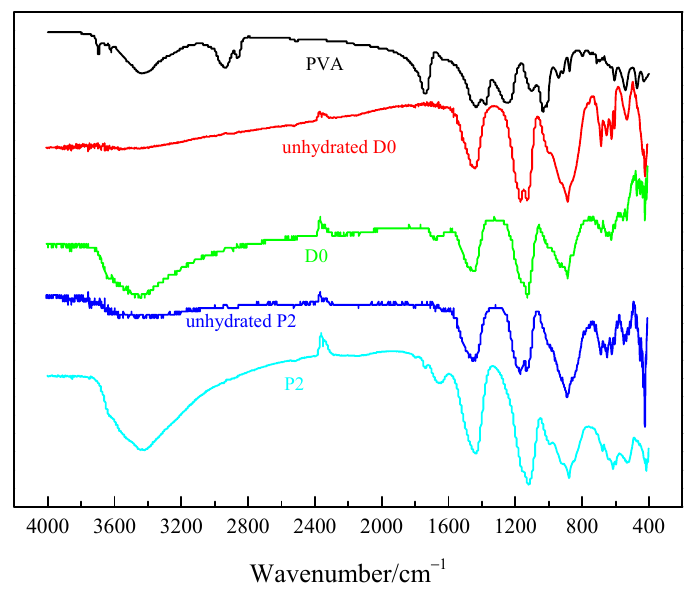
Figure 6. The infrared analysis diagram of material and cement.